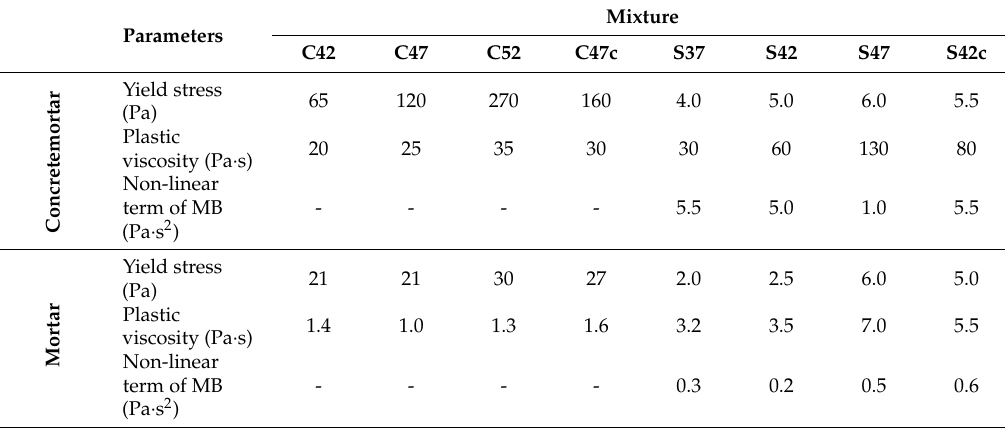
Table 3. The Bingham rheological parameters for CVC and the modified Bingham (MB) rheological parameter for SCC mixtures.